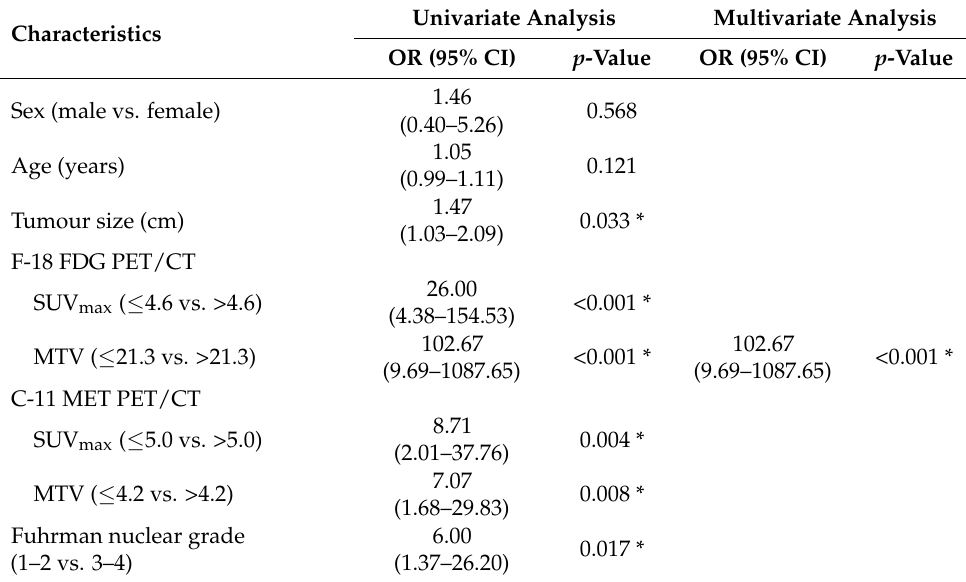
Table 2. Logistic regression results of renal cell carcinoma patients to predict advanced-stage disease (III and IV).